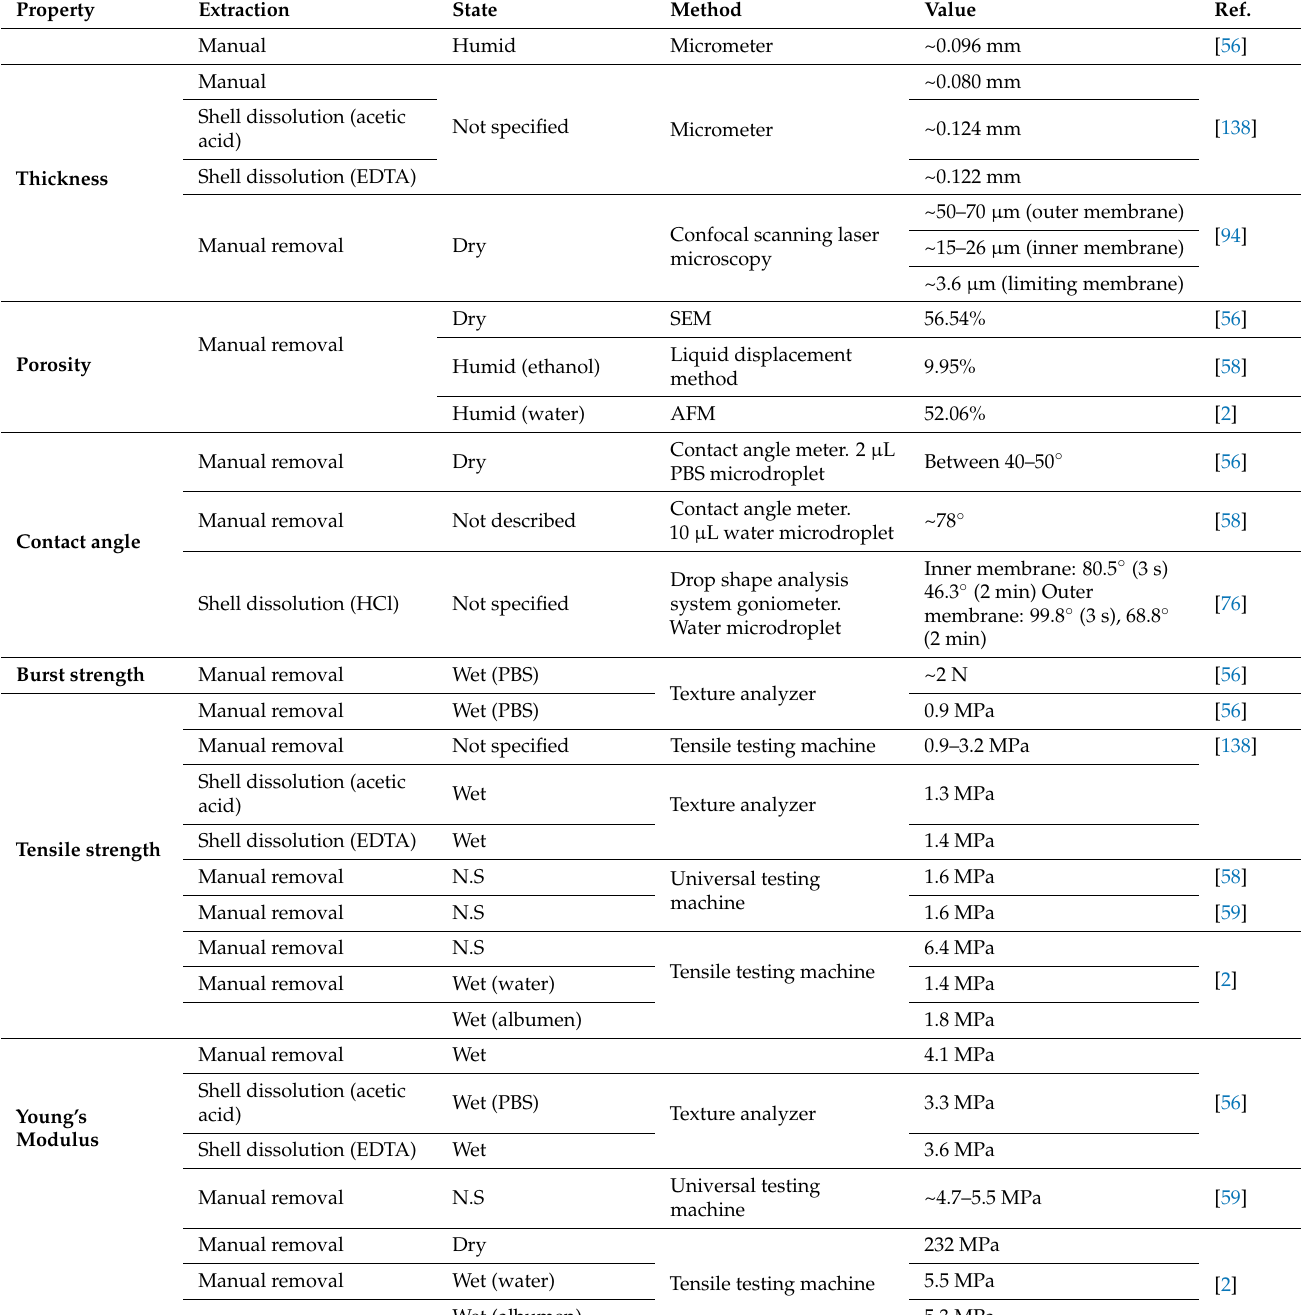
Table 6. Outcome of physical properties measurements and mechanical tests performed on the